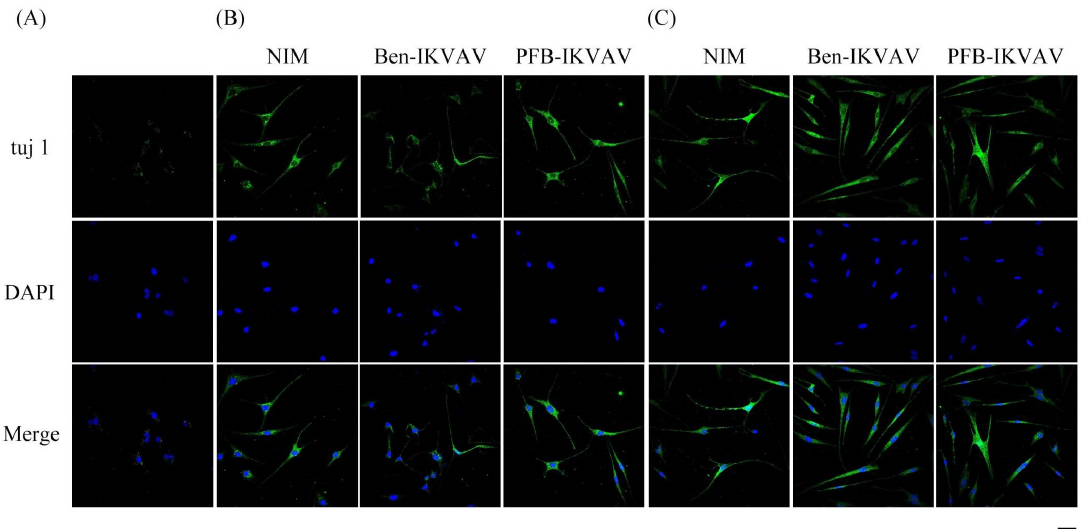
Figure 10. Representative images showing immunofluorescent staining of β -tubulin (tuj 1) expression in hMSCs cultured with NIM (control), NIM in the presence of Ben-IKVAV, and NIM in the presence of PFB-IKVAV for ( A ) day 1, ( B ) day 2, and ( C ) day 7. Upper: cells appear green in color due to the presence of β -tubulin-Ab; middle: nuclei appear blue due to staining with DAPI; lower: merged image. (Scale bar: 20 μ m.).